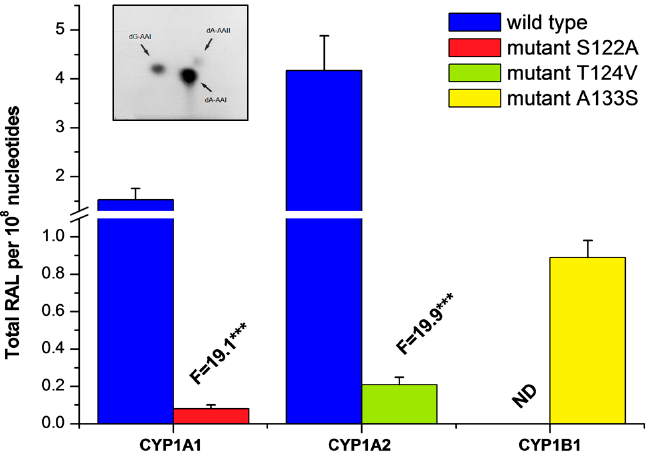
Figure 6. AAI-DNA adduct formation catalyzed by human wild-type CYP1A1, 1A2 and 1B1, and their mutants CYP1A1-S122A, CYP1A2-T124V, and CYP1B1-A133S reconstituted with rat POR in